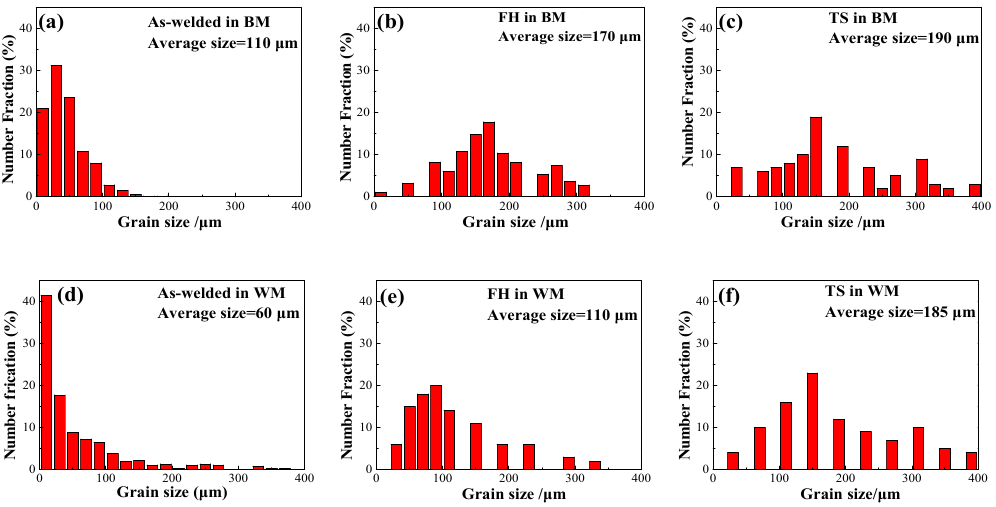
Figure 4. The grain-size distribution histograms of the as-welded ( a , d ), FX ( b , e ), and TS ( c , f ) samples at 1100 °C (base metal ( a – c ) and weld metal ( d – f )).